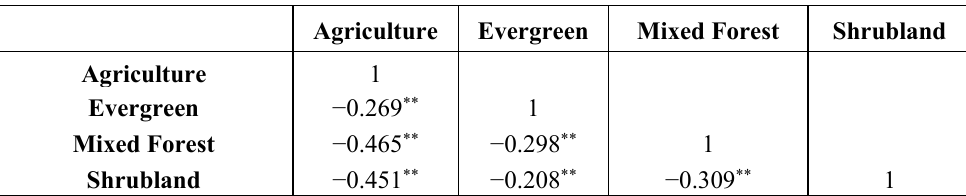
Figure 10. Percentage change of shrubland in each grid cell from 1990 to 2010. Table 3. Pearson’s correlation coefficient (r) between changes of land-cover/land-use (LCLU) categories during